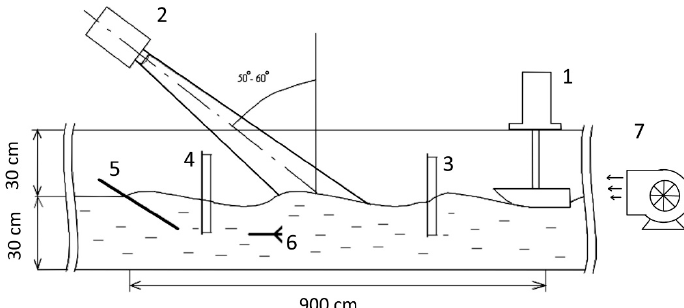
Figure 1. A photo of the Oval Wind Wave Tank OWWT ( top ) and the experimental setup ( bottom ). A wave maker is marked by 1, Ka-band scatterometer—2, wire gauge—3, 4, wave absorber—5, acoustic Doppler velocimeter (ADV)—6, ventilator—7.